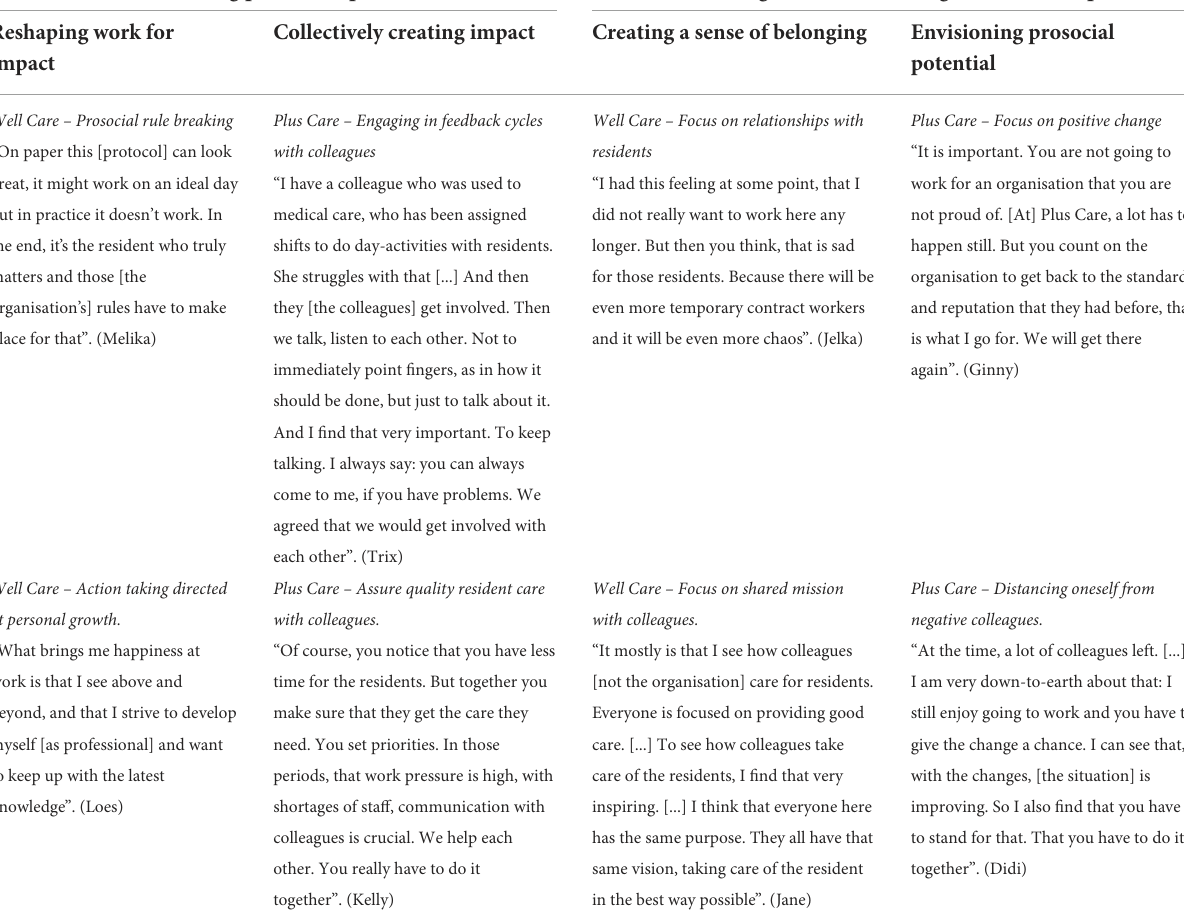
TABLE 3 Additional data table for cross-case comparisons: meaning infusing behaviours in the context of